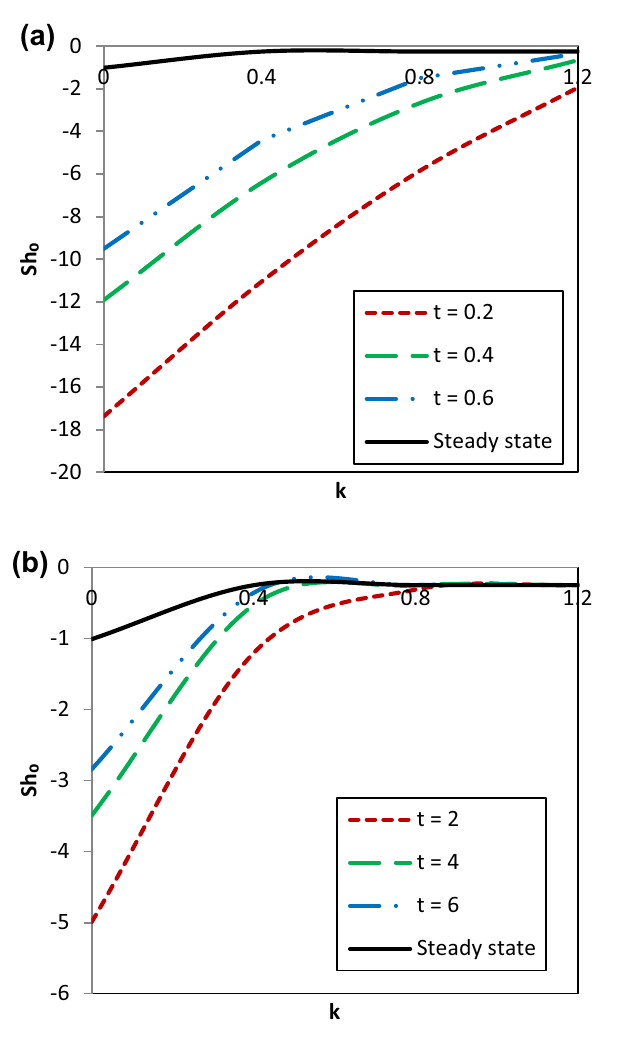
Fig. 6 a Variation of Sherwood number versus dimension- less thermophoretic coefficient for different values of time at y = 0 ( Pr = 0.71, Sc = 100, N b Variation of Sherwood number versus dimensionless thermophoretic coefficient for different values of time at y = 0 ( Pr = 0.71, Sc = 100, N